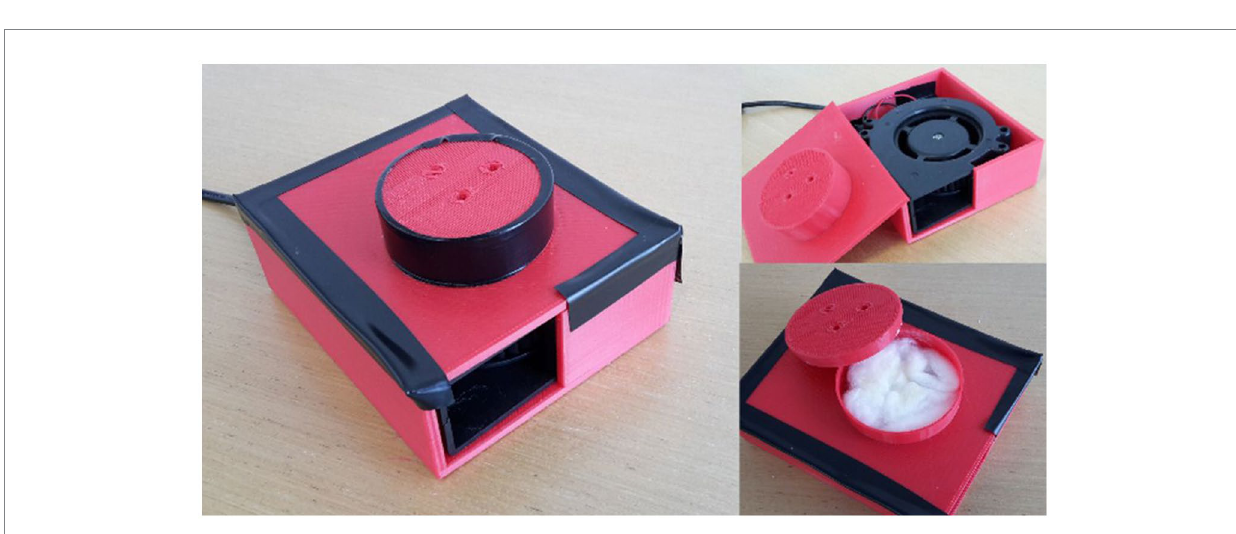
FIGURE 3 Olfactory device used to deliver the chocolate scent to the